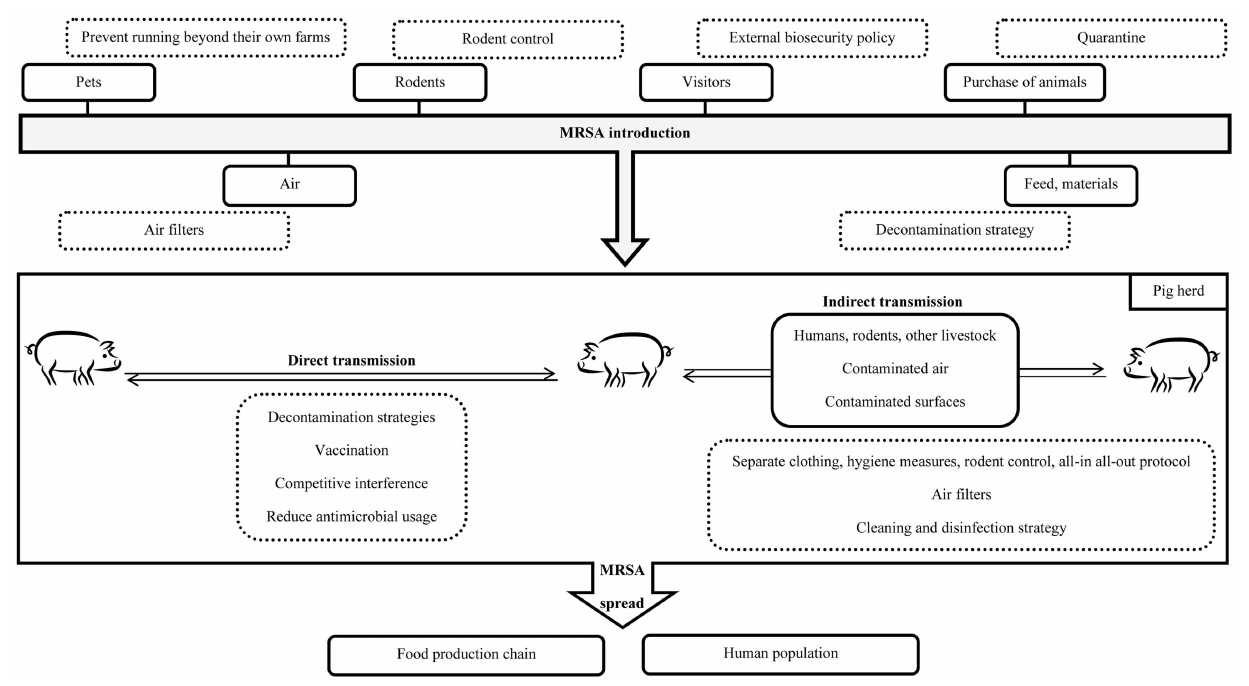
anti-staphylococcal antibodies. In fact, it is known that S.